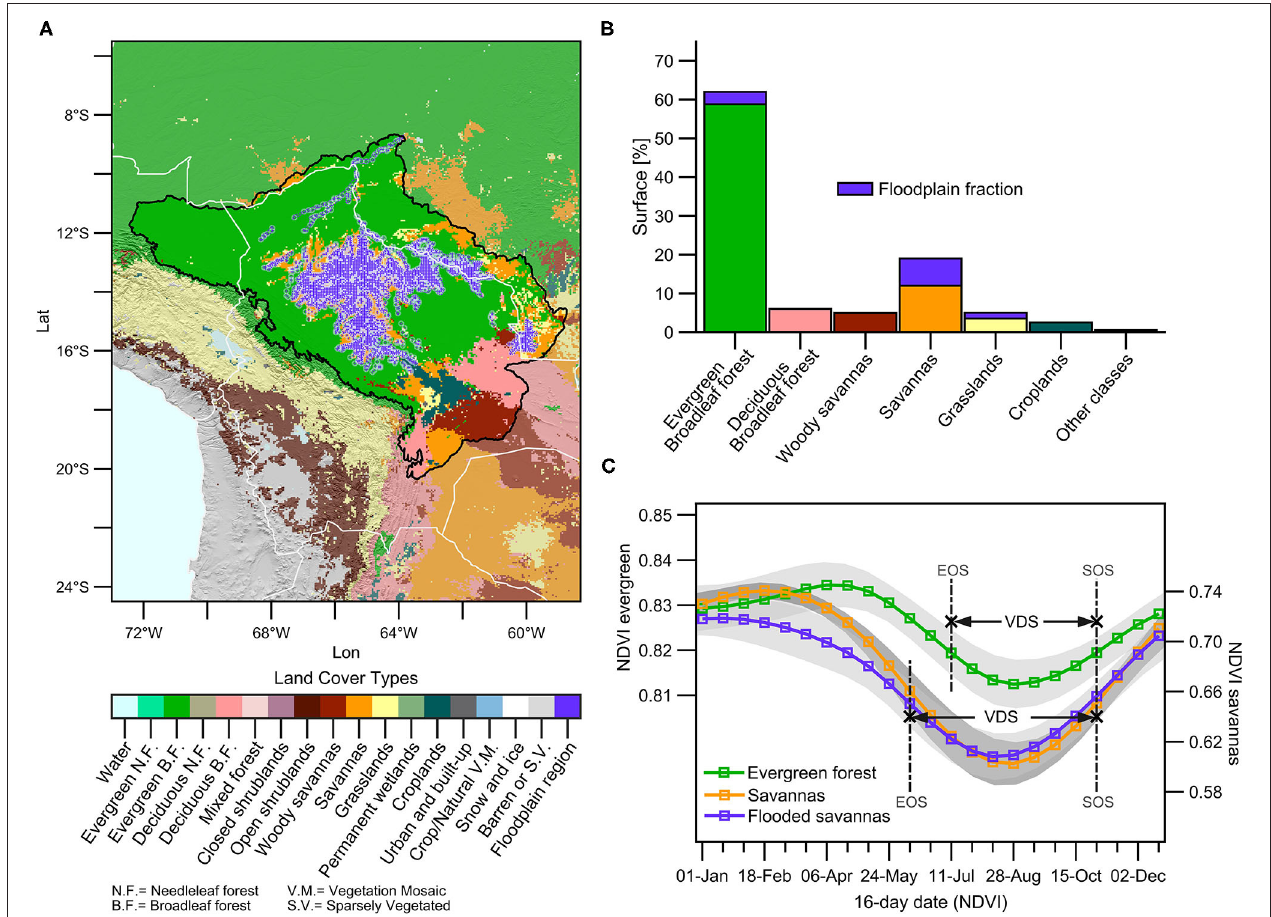
FIGURE 4 | (A) Spatial distribution of land cover types (IGBP classification), estimated from the MCD12C1 product over the upper Madeira Basin. The purple shades indicate the flooded areas, and the black line indicates the limit of the basin below 1,000 m.a.s.l, respectively. (B) Percentage of the surface of the upper Madeira Basin below 1,000 m.a.s.l that is covered by the land cover types considered. The percentage of the flooded area in each cover type is indicated in purple. (C) Mean NDVI annual cycle (lines) and its standard deviation (shades) of the predominant land cover types over the upper Madeira Basin below 1,000 m.a.s.l. The mean dates of the growing season end (EOS) and start (SOS), and the dry season period (VDS) for each predominant cover type is